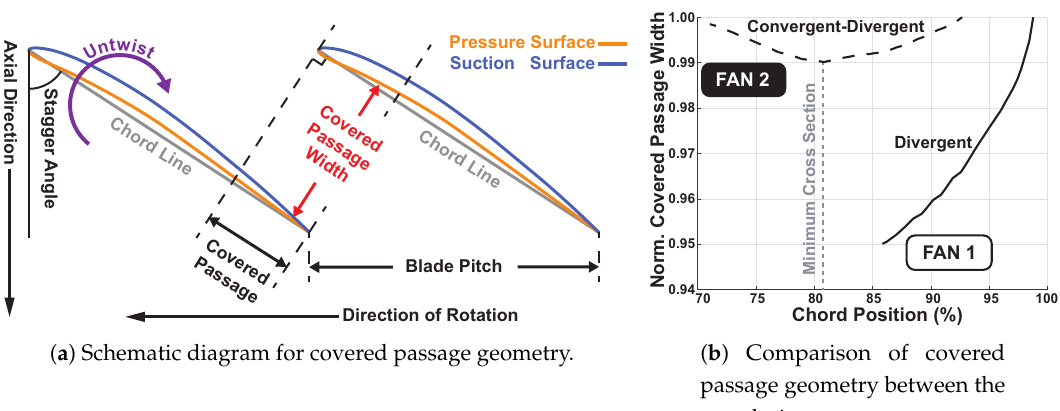
Figure 8. Covered Passage Geometry for nominal blade geometry.